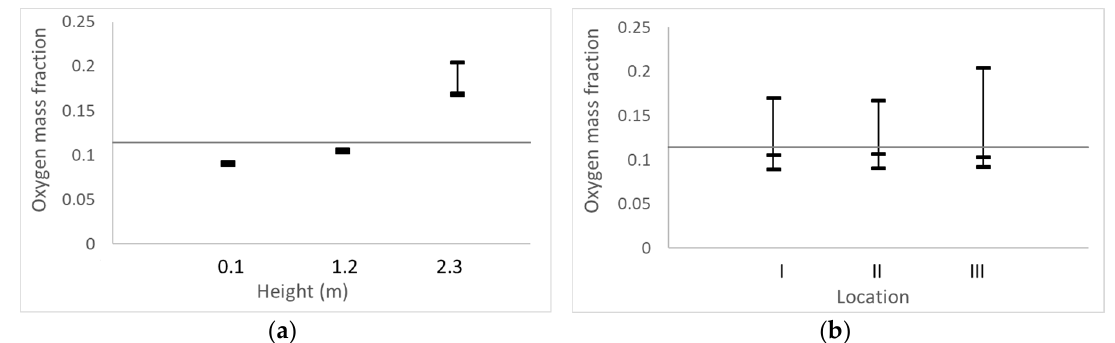
Figure 6. The lowest, median, and highest oxygen mass fraction at height 0.1, 1.2, and 2.3 m above the floor ( a ), and at locations I, II, and III at 100 s for case series C0_541_1.0 ( b ).